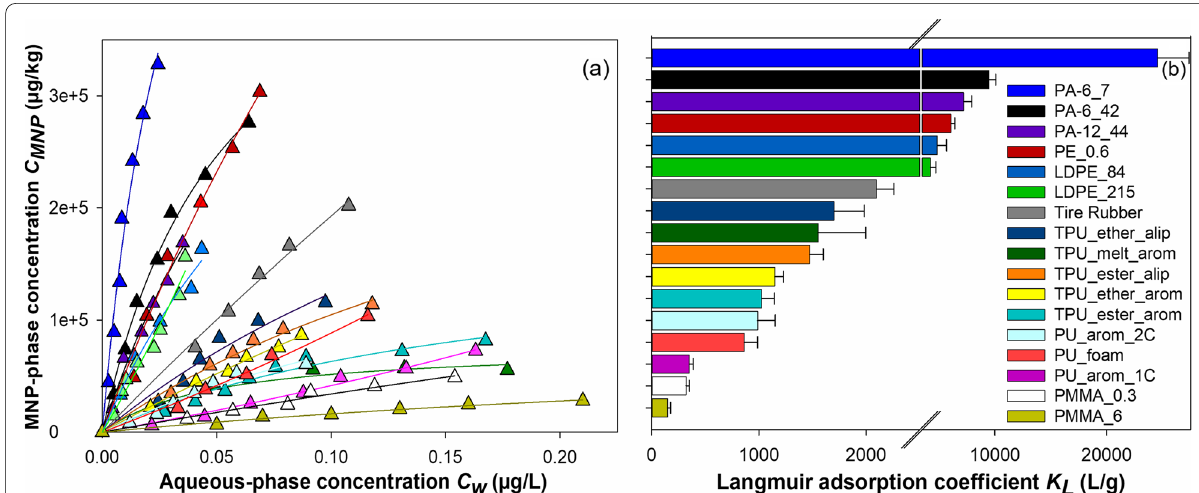
Fig. 3 a Experimental sorption isotherms for B[ a ]P and MNPs fitted to the Langmuir model. b : Ranking of B[ a ]P sorption to MNPs based on Langmuir adsorption coefficients K L (error bars represent standard errors of K L